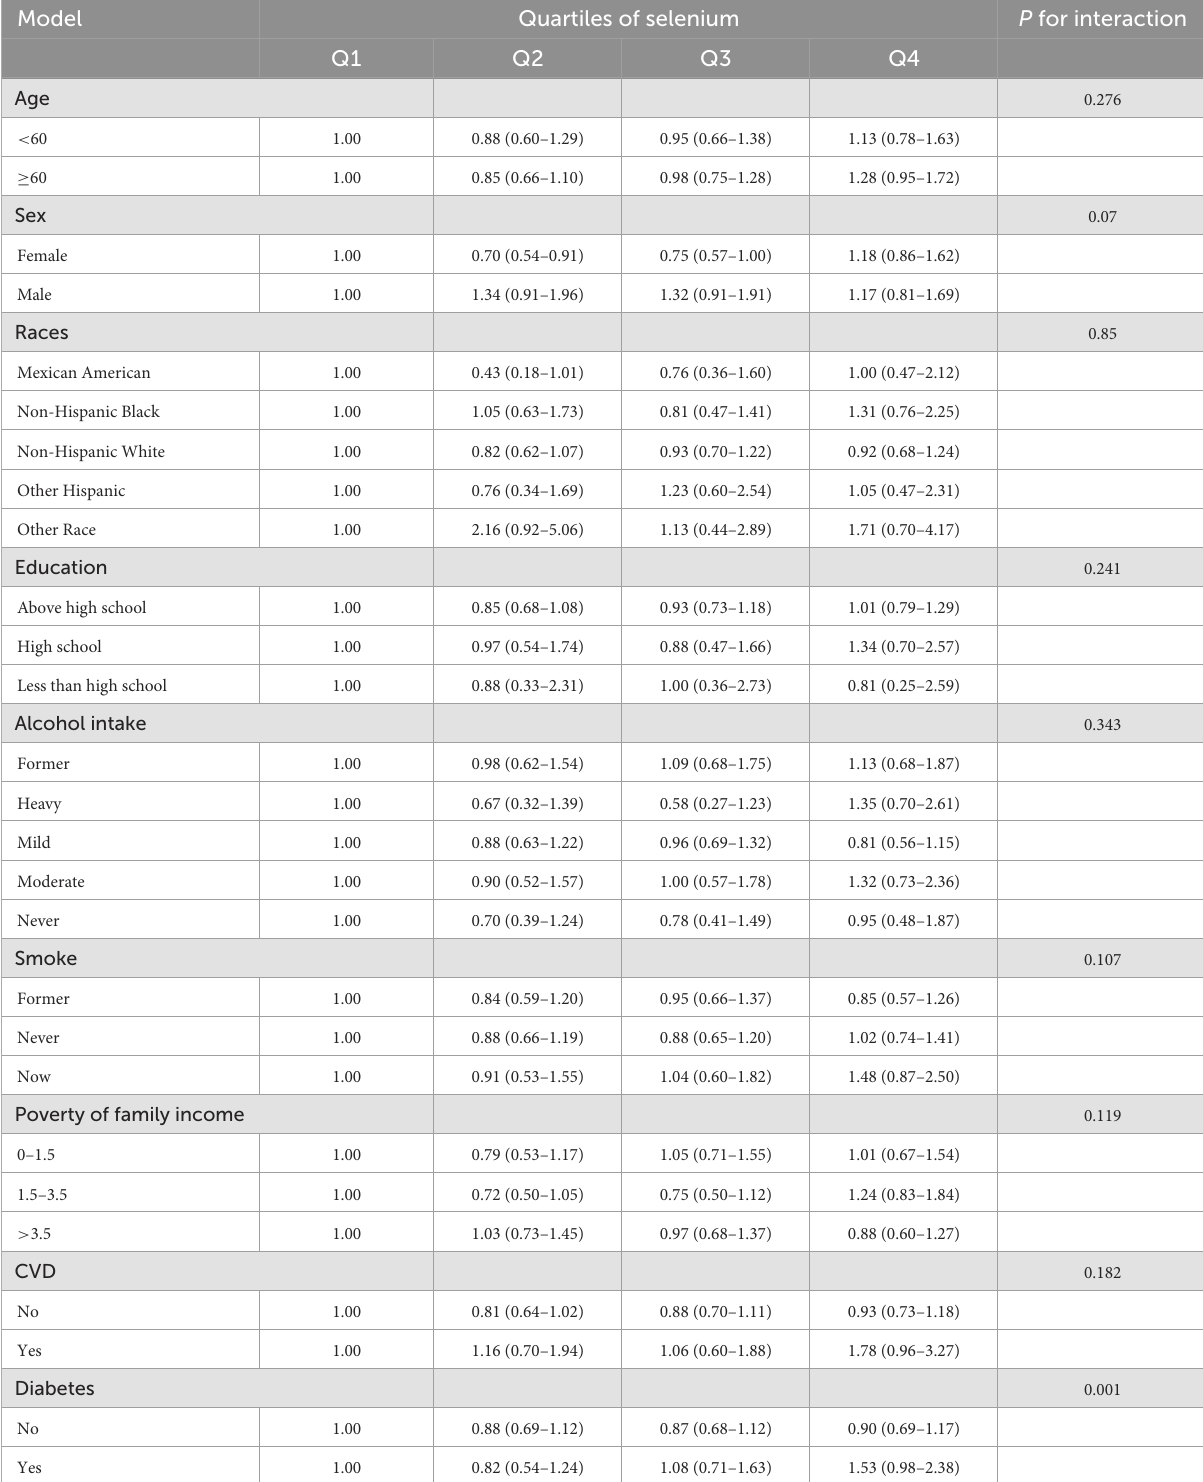
TABLE 5 Subgroup analysis between dietary selenium quartiles and osteoarthritis